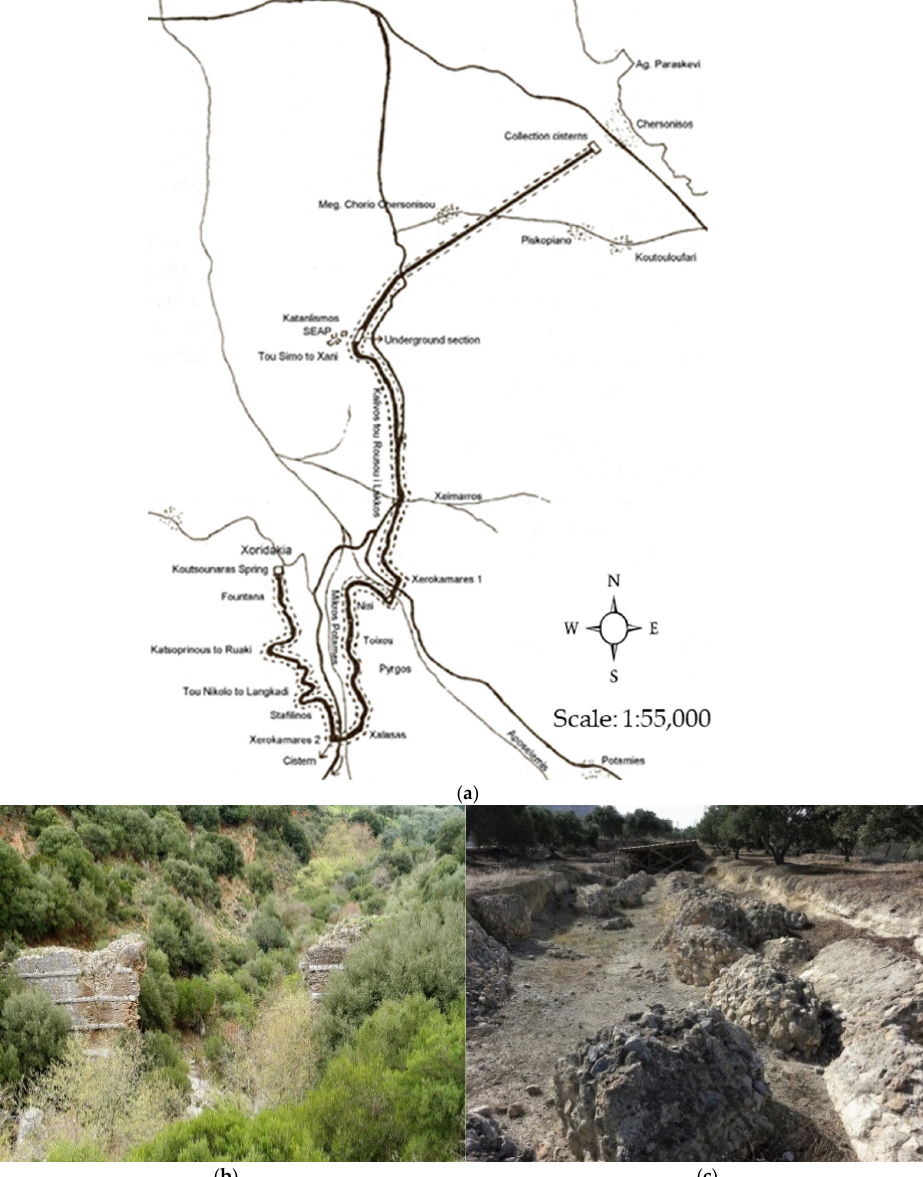
Figure 7. Chersonisos aqueduct: ( a ) the layout (scale: 1:55,000) [28] , ( b ) remnants of a water bridge and ( c ) Cistern complex in Piskopiano (photos by A. N. Angelakis).